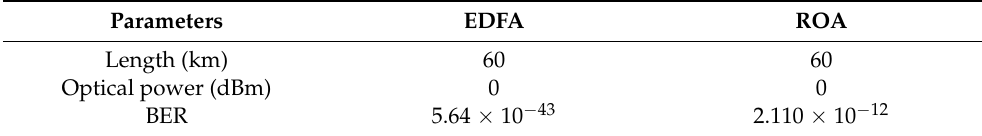
Table 4. Parameters and results of 8-channel CWDM [22].